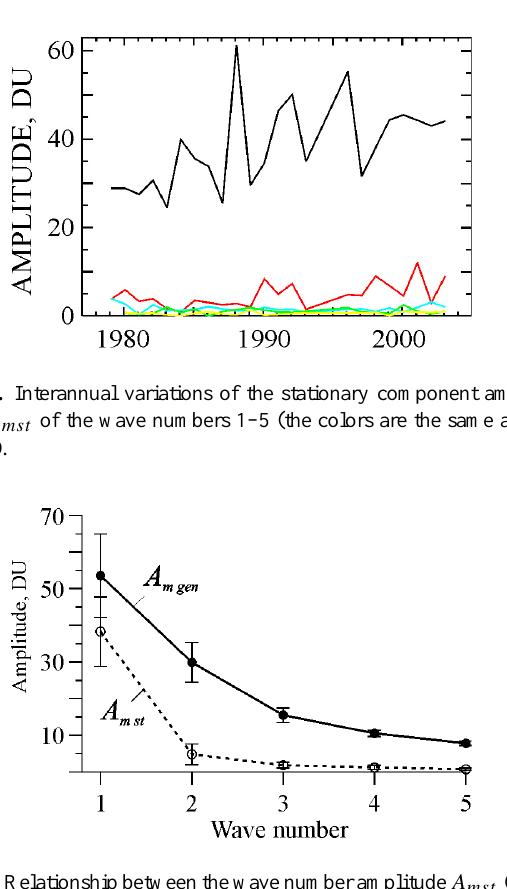
Fig. 9. Relationship between the wave number amplitude A mst (sta- tionary) and A mgen (general), averaged for the 1979–2003